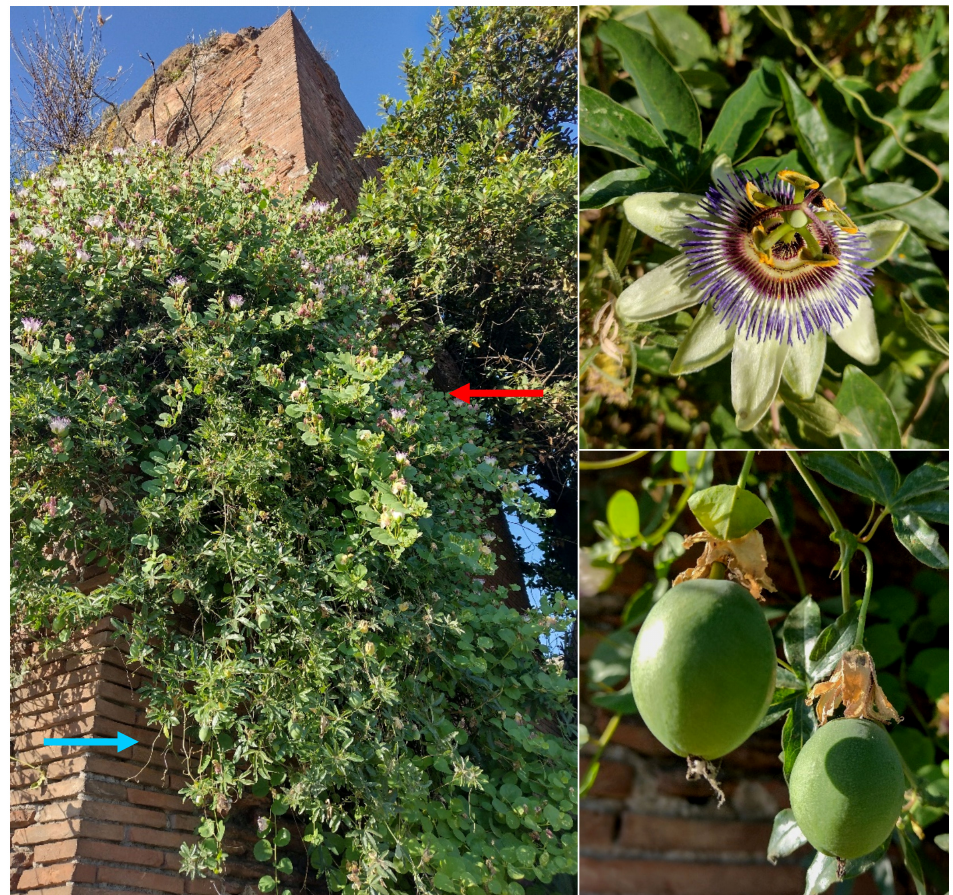
Figure 62. Passiflora caerulea (blue arrow) associated with Capparis orientalis (red arrow) on the ancient Roman Claudio’s aqueduct.